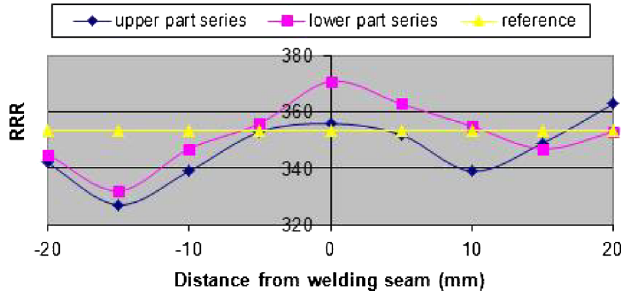
FIG. 15. RRR in welding area (electron beam welding at pressure 2 : 3 (cid:2) 10 (cid:4) 8 mbar